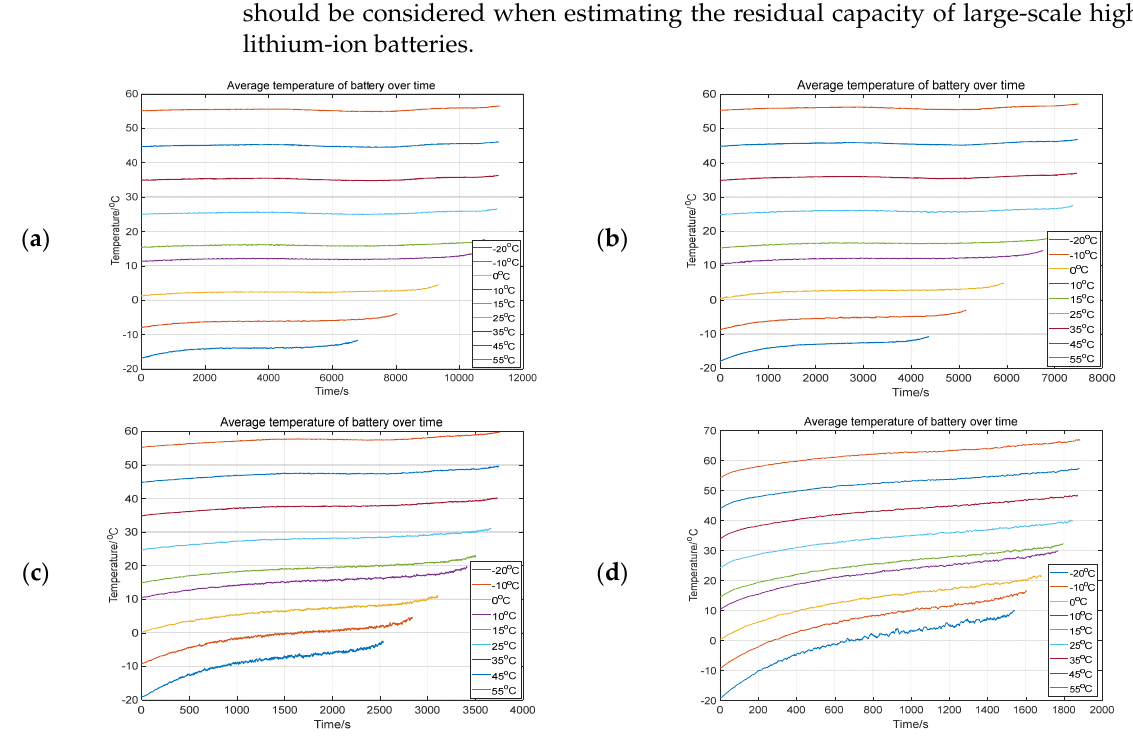
Figure 8. The temperature of the battery changes with time under the rate of ( a ) 1/3C, ( b ) 1/2C, ( c )1C, ( d ) 2C.